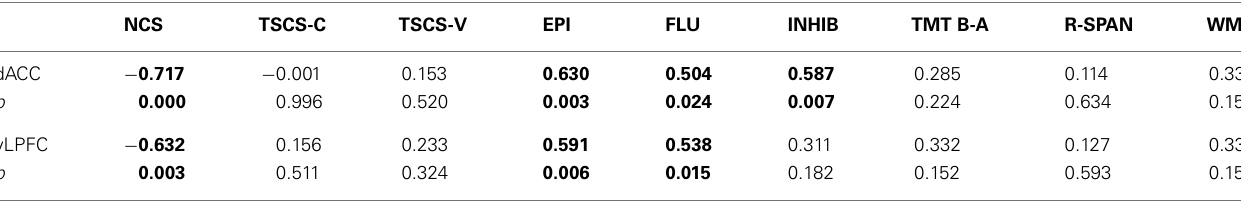
Table 4 | Correlations between brain activity self-concept, episodic and neuropsychological scores.